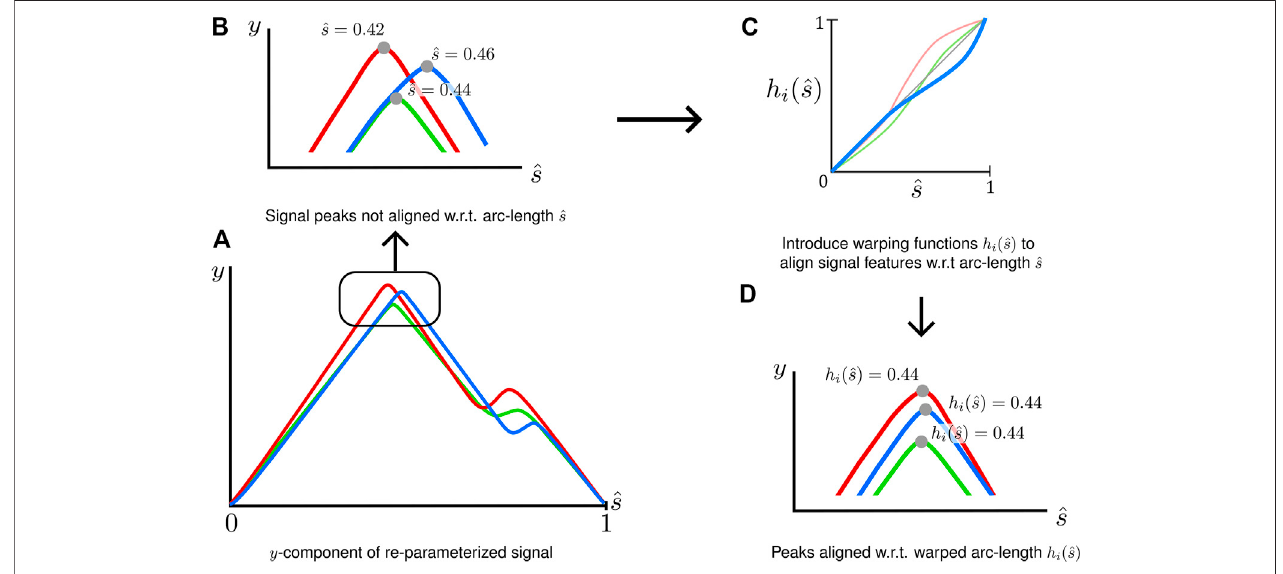
FIGURE3| Agraphicaldepictionofthesignalregistrationprocesstoaligncriticalfeatures (A) Signalsinthearc-lengthspacemaynothavekeyfeaturesaligned. (B) Peaks occurring adifferent normalized arc-lengths (C) Warping functions are introduced for each signal h i ( ^ s ) that remap the normalized arc-length of each signal (D) to align features. Signal registration operates on arc-length, not the underlying ( x , y ) data of the signal.